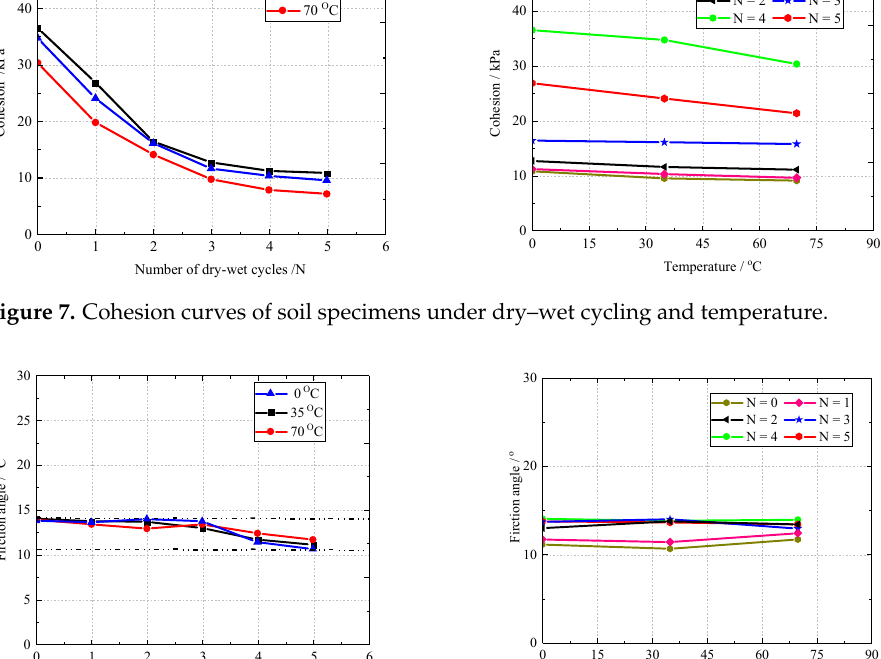
Figure 7. Cohesion curves of soil specimens under dry–wet cycling and temperature.